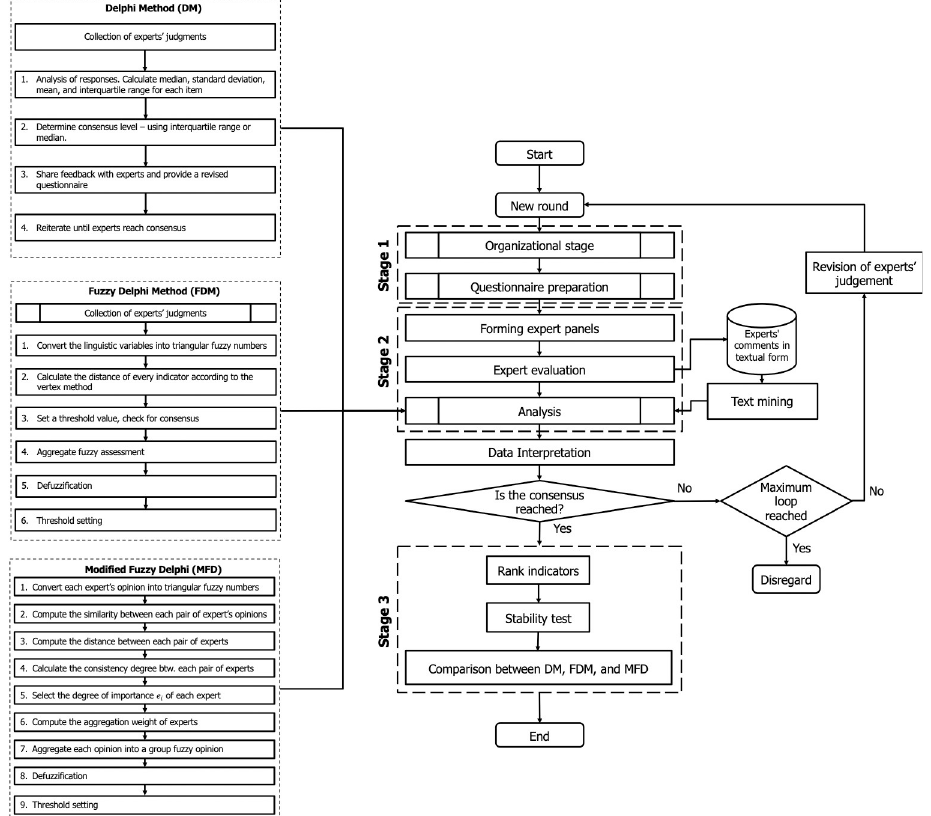
Fig 1. The flowchart of the modified fuzzy Delphi (MOFD)